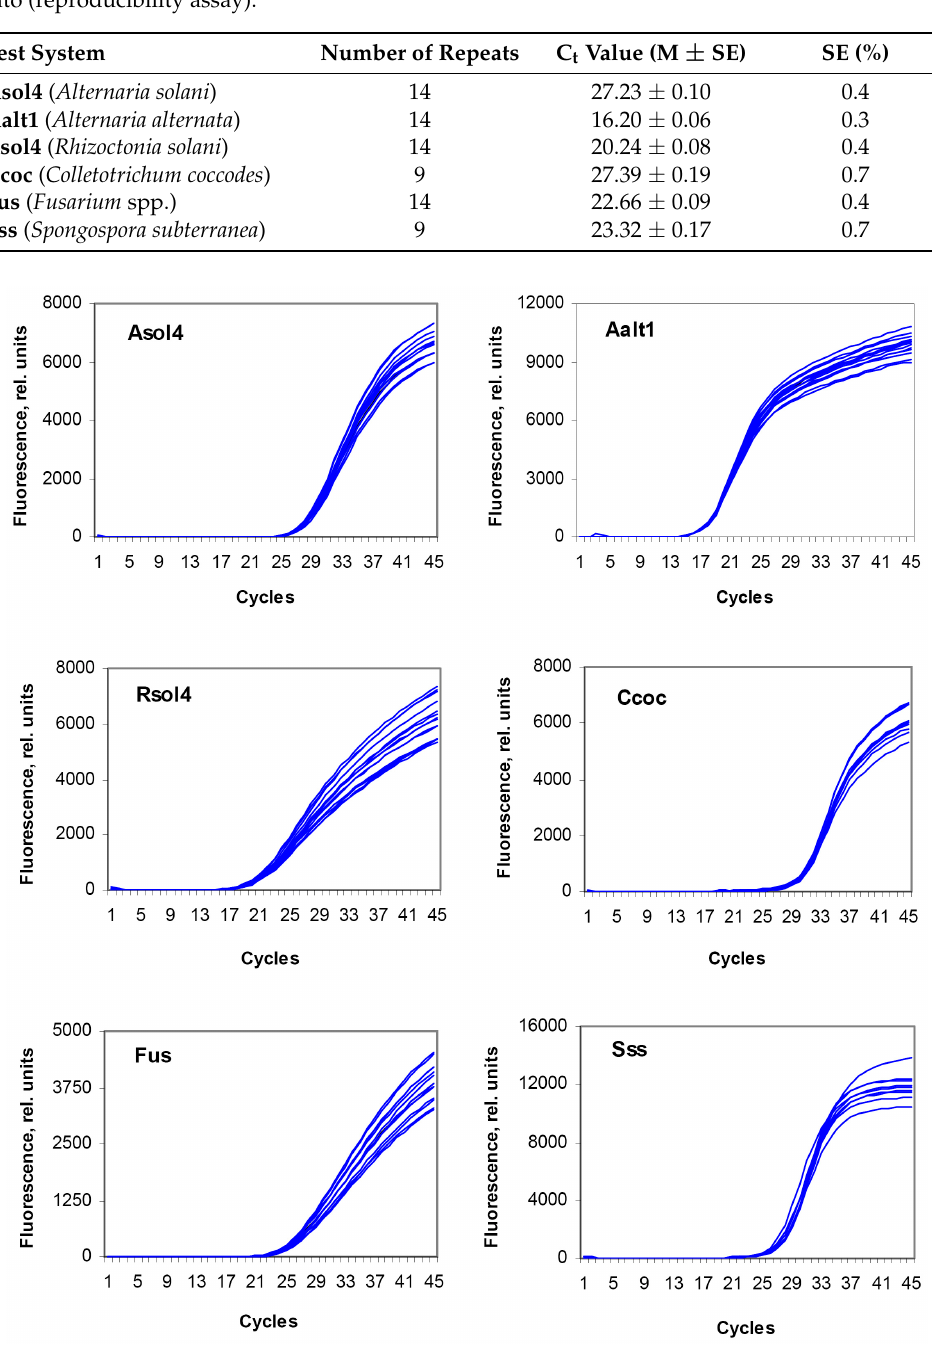
Figure 3. Reproducibility of the test systems for detection of the target potato pathogens.